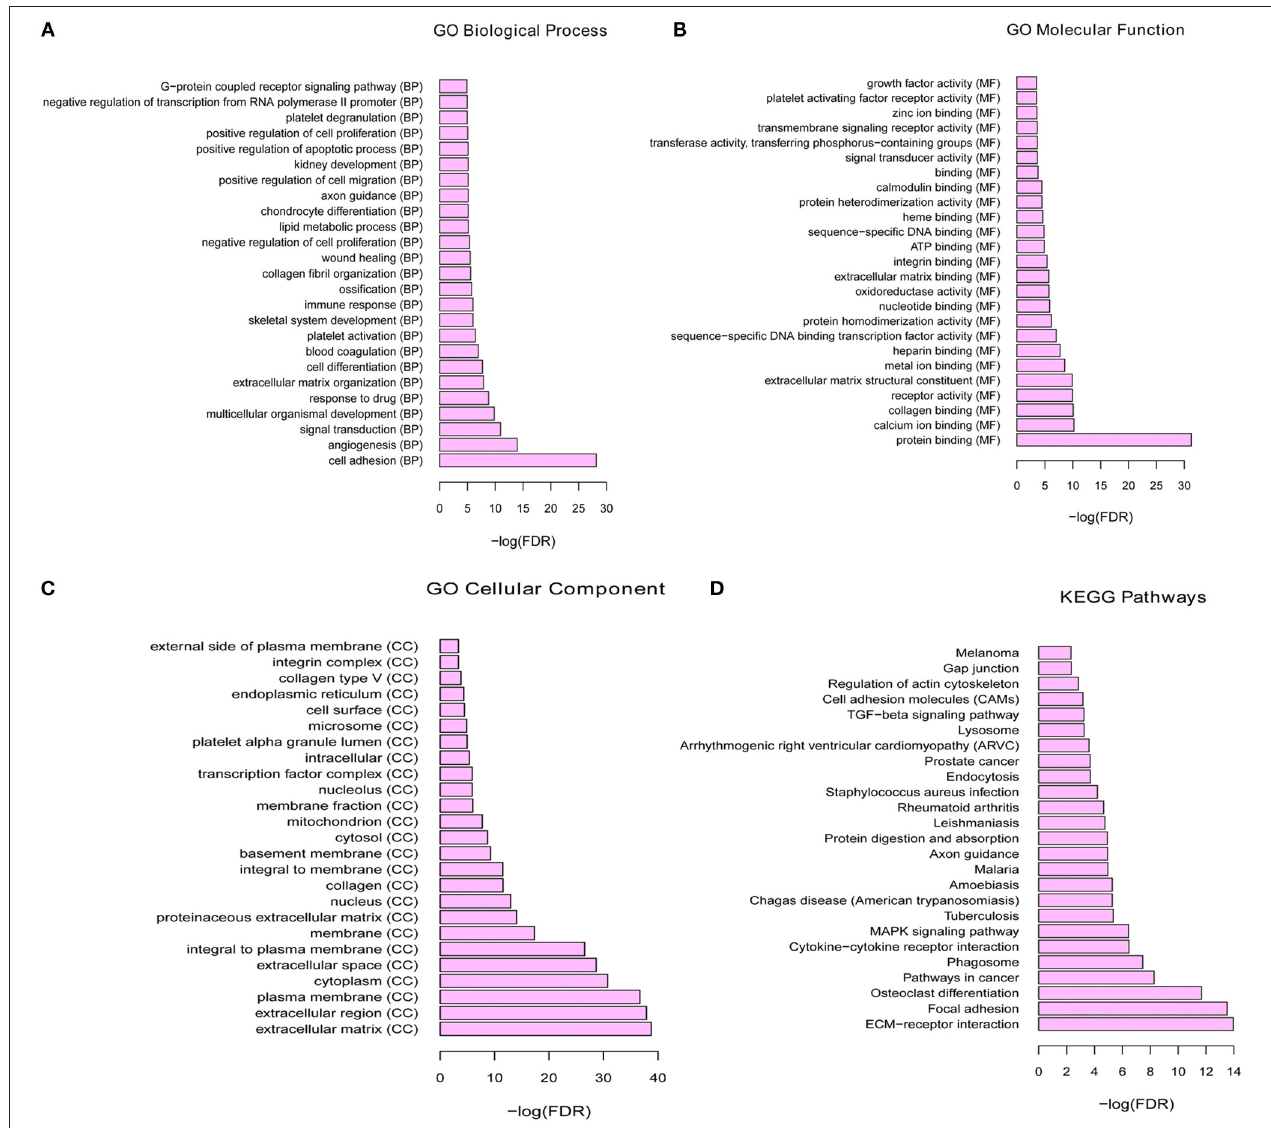
FIGURE 2 | The functional enrichment of GO terms and KEGG pathways for differential mRNA. (A) Top 25 significant enrichment biological processes of DEGs. (B) Top 25 significant enrichment molecular functions of DEGs. (C) Top 25 significant enrichment cellular components of DEGs. (D) Top 25 significant enrichment KEGG signal pathways of